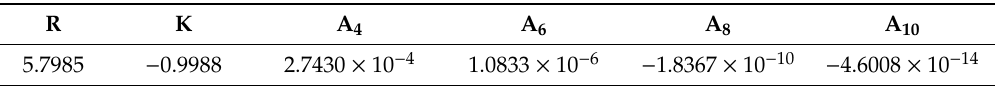
Table 2. Aspheric coe ffi cients of the compensated mold.